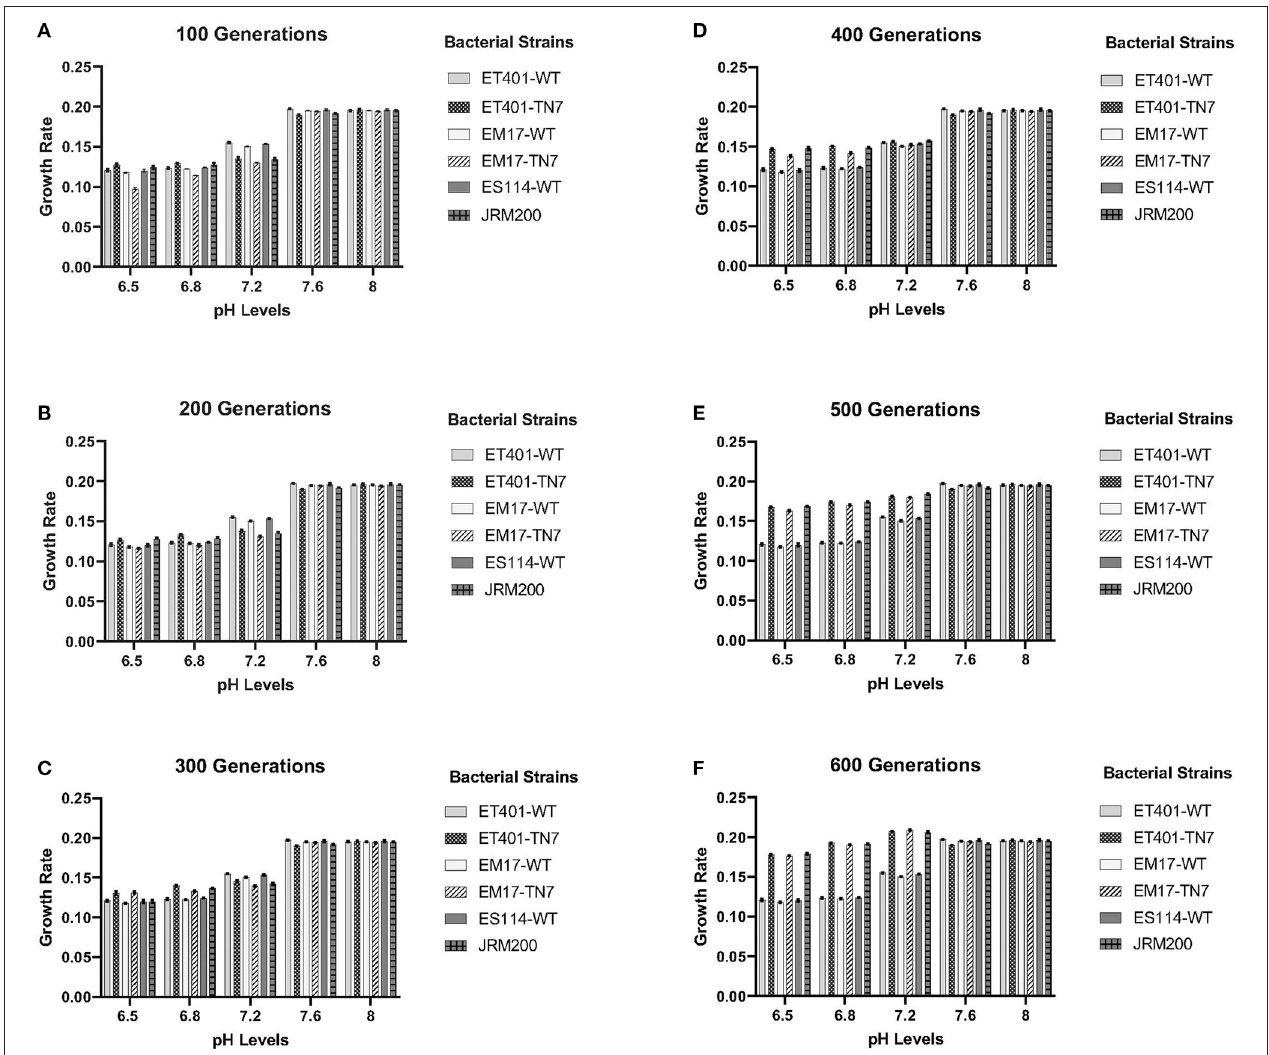
FIGURE 1 | (A–F) Growth rates of ancestor and evolved strains from 100 to 600 generations for pH levels of 6.5–8, respectively. See Table 1 for strain